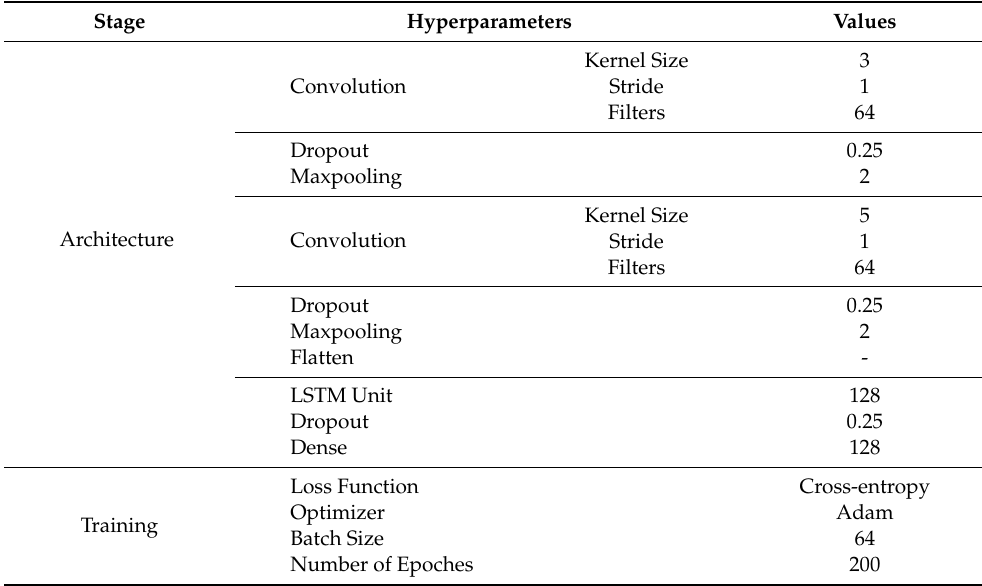
Table 7. The summary of hyperparameters for the DeepConvLSTM network used in this work.